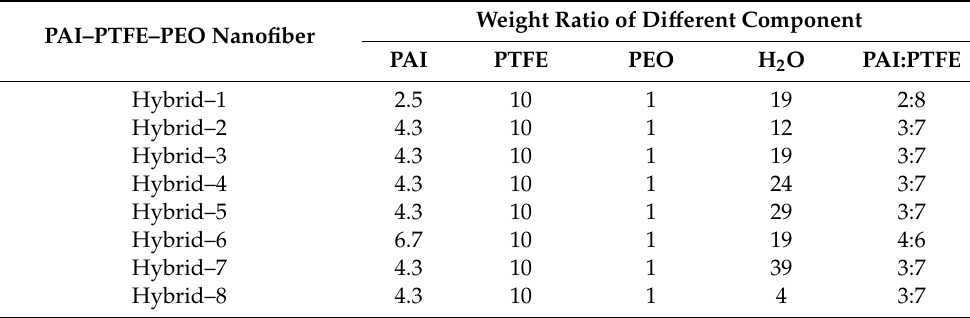
Table 1. The formula of PAI–PTFE–PEO solution used for electrospinning.